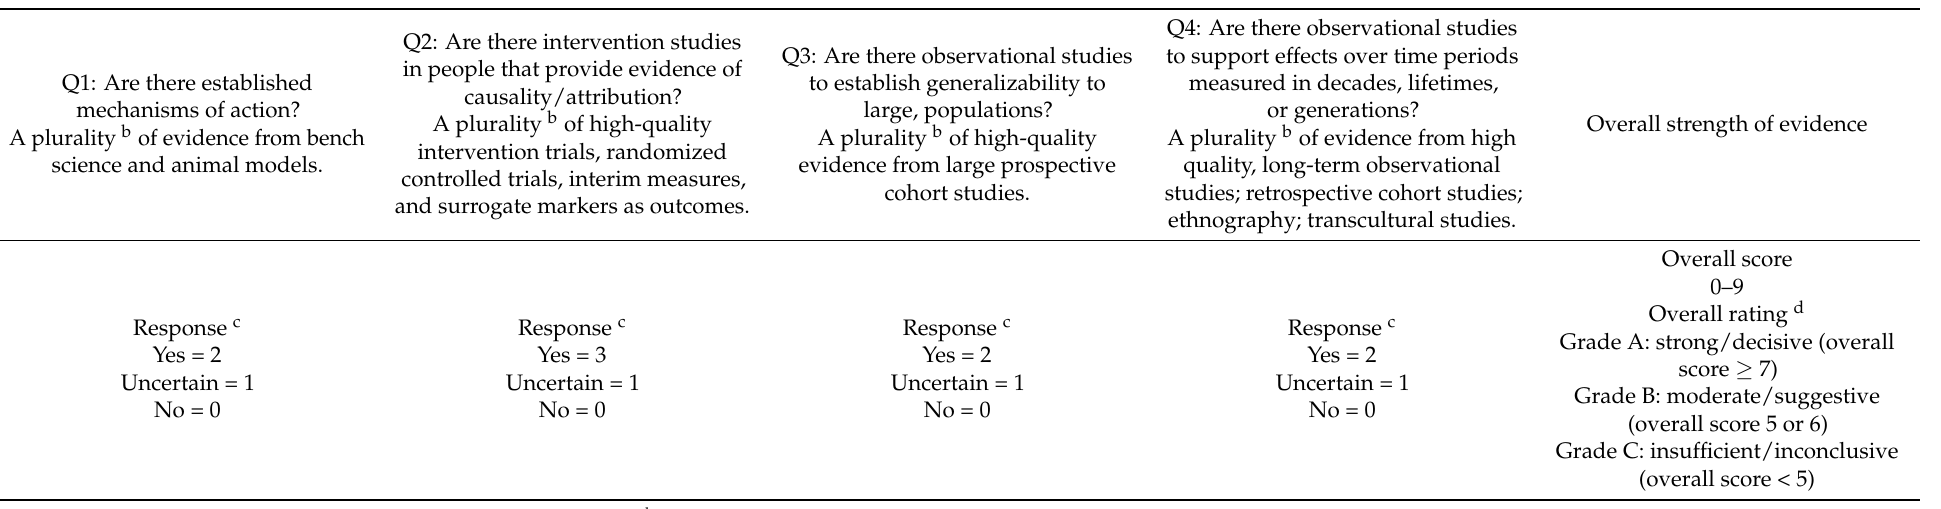
Table 1. Overview of the Hierarchies of Evidence Applied to Lifestyle Medicine (HEALM) approach a .